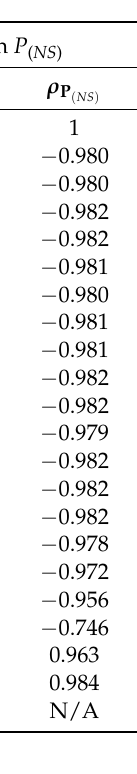
Table 4. Correlation % between for given P ( NS ) levels and ∆ t , which indicates the dependence between travel delay and the probability of